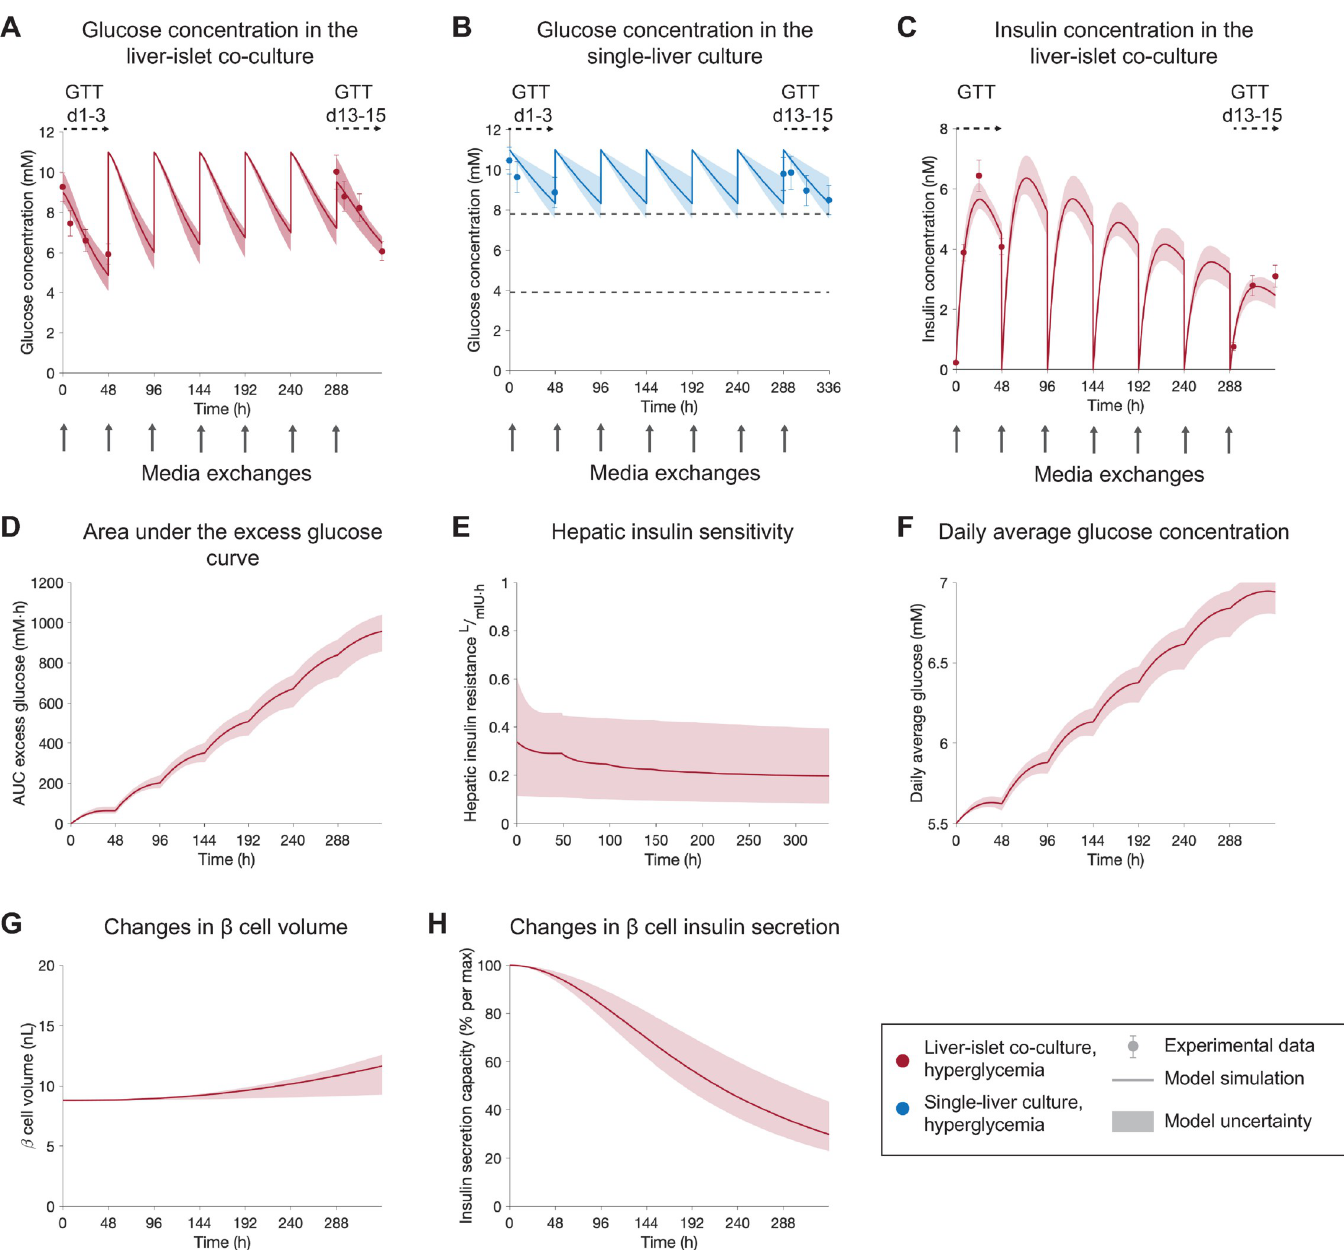
Fig 4. Model-based analysis of the physiological processes behind impaired glucose homeostasis in the co-culture. The results correspond to experiment 2 [18]. A-C : Comparison between experimental measurements (markers) and model simulations (lines) of glucose concentration in the co-cultures (A) , in single-liver cultures (B) , and insulin concentration in the liver-islet co-cultures ( C ). Co-cultures were exposed to hyperglycemic medium (11 mM glucose) at each media exchange (grey arrows). Experimental time-series were acquired during GTTs initiated at day 1 (GTT d1-3) and day 13 (GTT d13-15). The mechanistic variables inferred by the model, which can explain the experimental data in (A-C) are shown in (D-H). (D) Time-integral or area under the curve (AUC) of excess glucose (i.e. difference between glucose levels in the co-culture media and 5.5 mM) over time. This accounts for the effect of exposing the HepaRG/HHSteC spheroids to periods of hyperglycemia during the co-culture time, with the associated decrease in hepatic insulin sensitivity (E) and rise in daily average glucose levels ( F ). Changes in β -cell insulin-producing capacity predicted by the model are caused by an increase in pancreatic β -cell volume ( G ) and a decay in the individual secretion capacity of β cells over time ( H ). Model uncertainty is depicted as shaded areas in panels A-H . Data in panels A-C are presented as mean ± SEM, n = 5. n: Number of platform replicates included in the